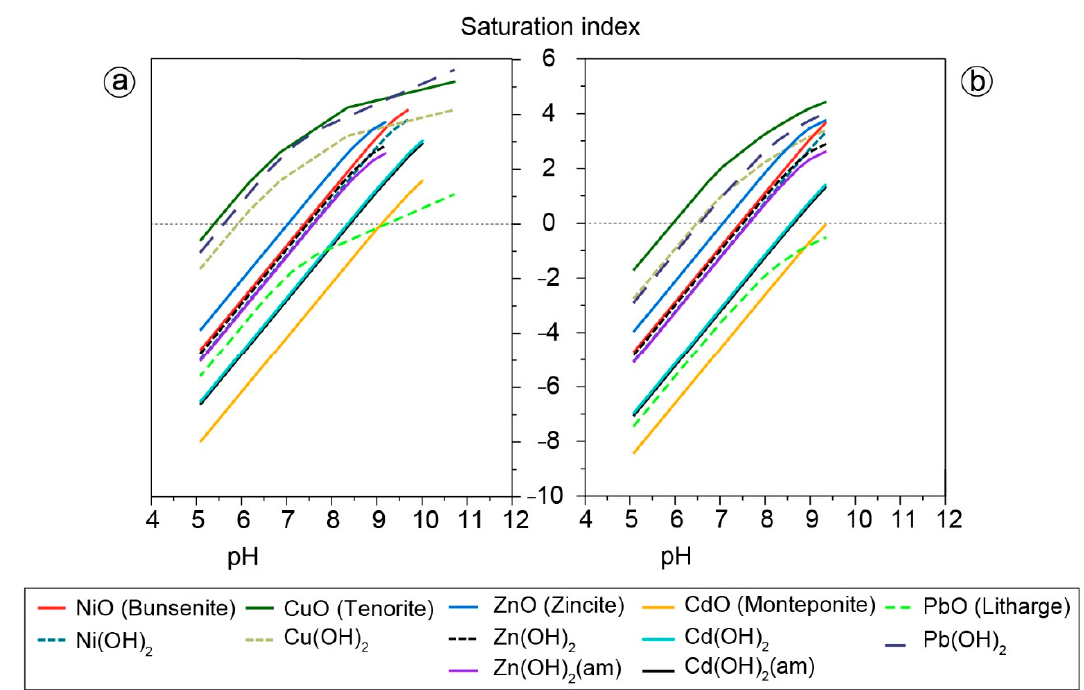
Figure 9. Variation of the saturation index of metal oxides and hydroxides with pH in the most concentrated solutions in batch tests: ( a ) individual contaminated solutions; ( b ) multielemental solutions.